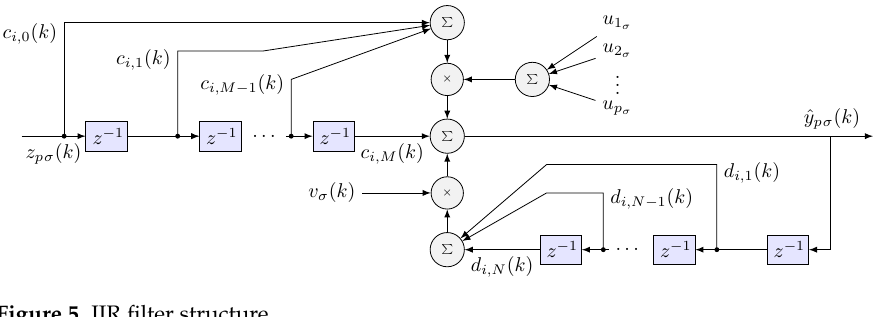
Figure 5. IIR filter